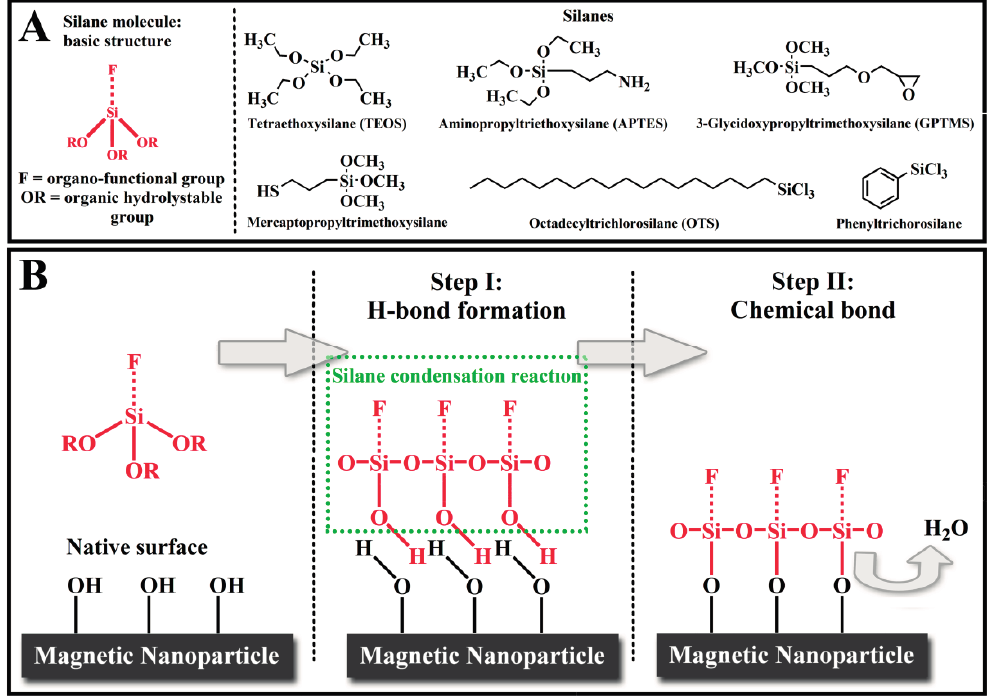
Figure 1. Chemical structures of mostly used silane precursors for surface functionalization and silanization reaction mechnism on magnetic nanoparticle. ( A ) Organo-functional silane molecule structures contain two different basic reactive groups: an organic hydrolyzable group (OR) and an organo-functional group (F); ( B ) Schematic of the condensation reaction between silane molecules and an oxide surface. The Si–OR bonds hydrolyze readily with water to form silanol Si–OH groups, which can then condense with each other to form polymeric structures with hydroxyl groups on the material